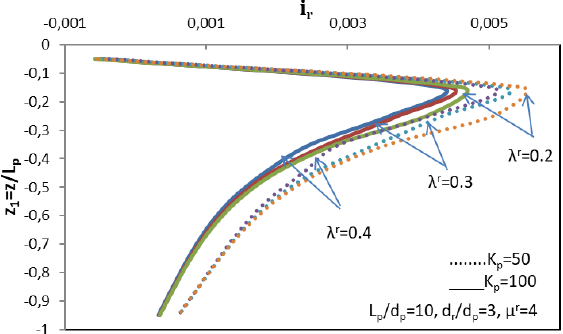
L ), p p =z/L – effect 1 p , of GP on a p